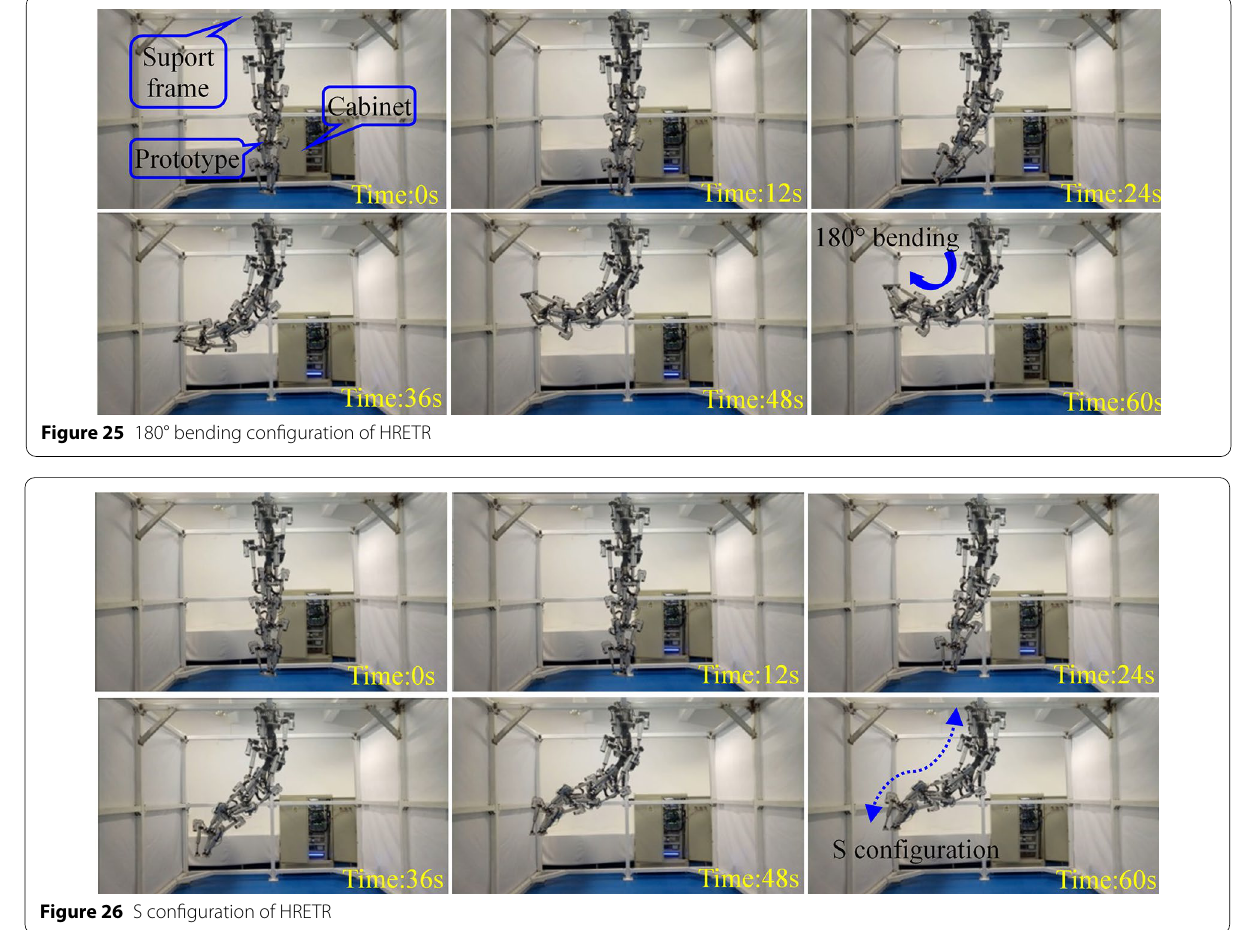
Figure 26 S configuration of HRETR